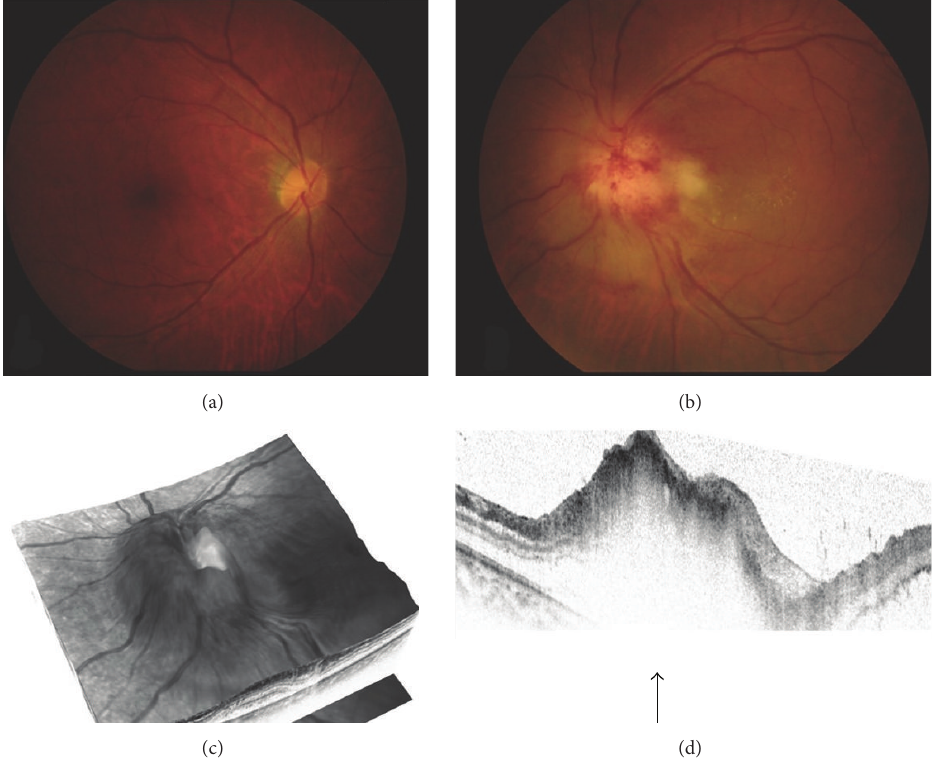
Figure 1: Fundus photographs and optical coherence tomographic (OCT) images of a patient with hematopoietic malignancy. ((a) and (b)) Color fundus photographs show severe left optic disc elevation with peripapillary hemorrhages and subretinal fluid. ((c) and (d)) OCT images of the left eye. The black arrow points to the optic